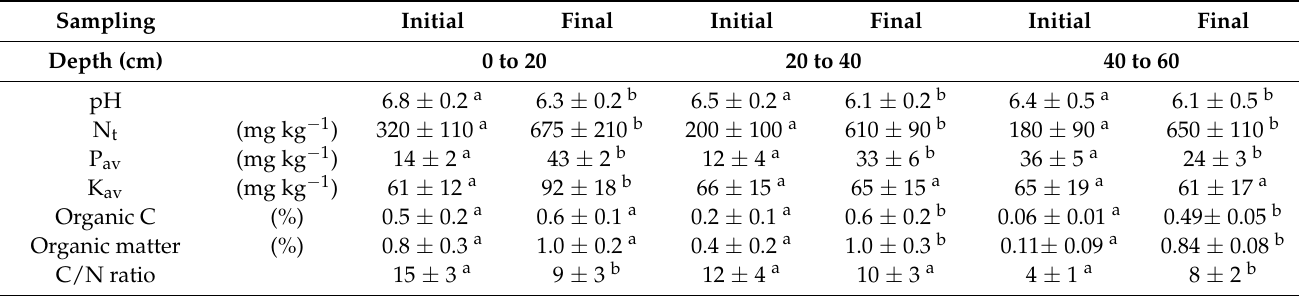
Organic C Organic